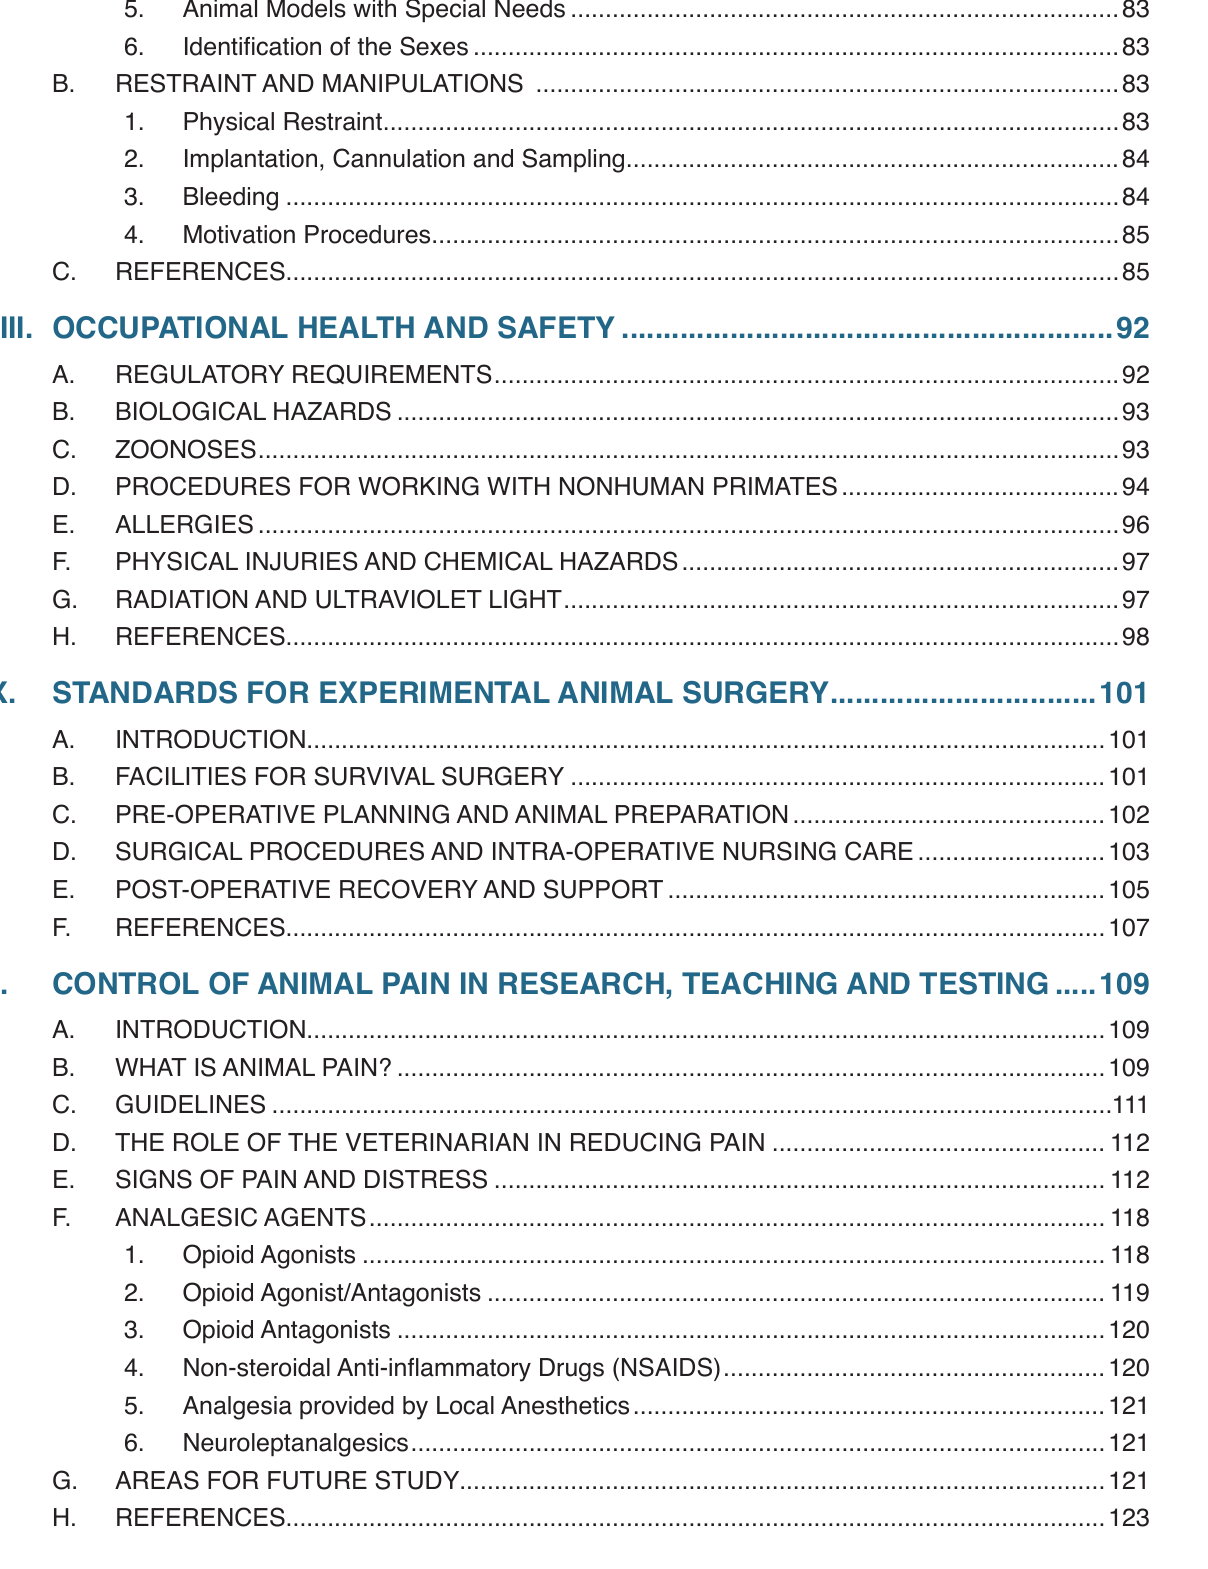
Guide to the Care and Use of Experimental Animals, Volume 1, 2 nd